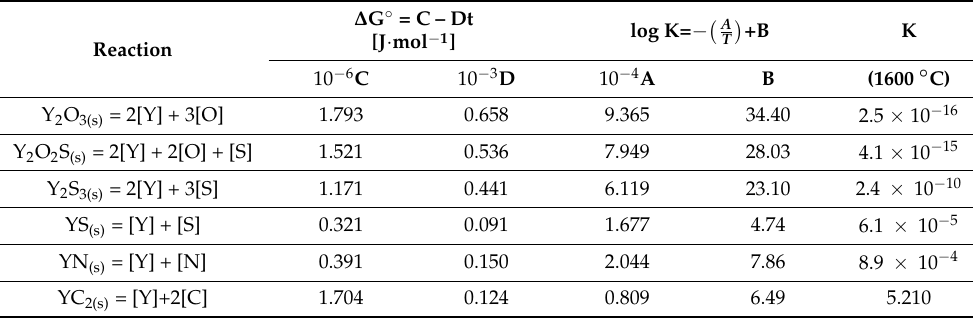
Table 1. Standard Gibbs energy and equilibrium constants of the reaction with yttrium in the temperature range 1575–1625 ◦